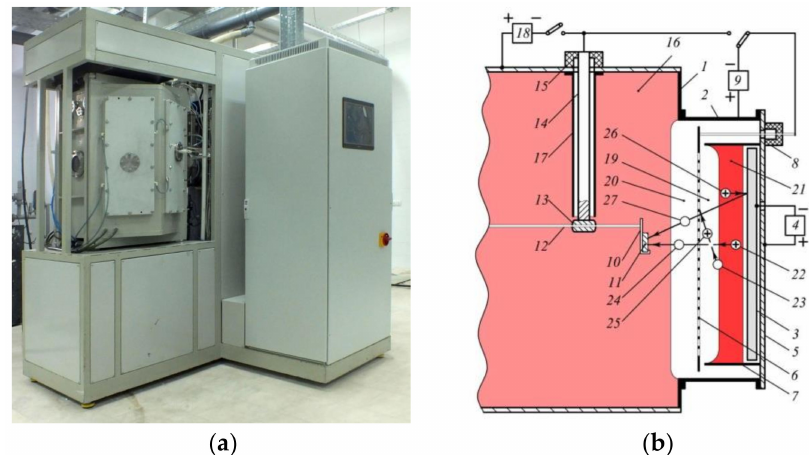
Figure 3. The experimental technological plant for coating the ceramics: ( a ) the general view; ( b ) the schematic diagram of its operation, where (1) is the vacuum chamber; (2) is the housing of the plant; (3) is the target of the magnetron; (4) is the power supply magnetron; (5) is the magnetron flange; (6) is the accelerating ions grid; (7) is the anode plate; (8) is the place of input voltage; (9) is the generator of high-voltage pulses; (10) is the holder of ceramic samples; (11) is the ceramic sample; (12) is the rod; (13) is the bushing; (14) is the input rod (terminal) of voltage; (15) is the high-voltage insulator; (16) is the discharge plasma in the chamber; (17) is the grounded screen; (18) is the reference voltage source; (19) and (20) are the layers of positive space charge; (21) is the discharge plasma near the target; (22) is the argon ion, accelerated by a grid; (23) is the gas molecule; (24) is the fast argon atom; (25) is the slow ion formed during charge exchange; (26) is the ion that sprays the target; (27) is the atomized metal